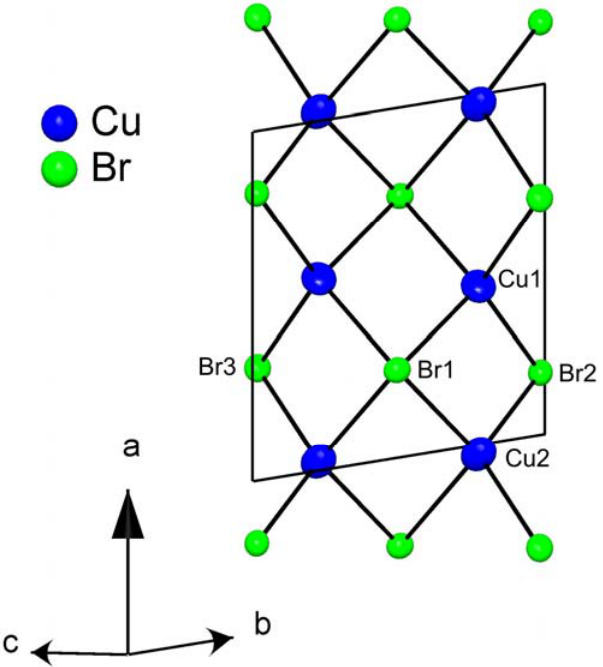
Figure 1. View onto a [Cu are labeled according to Table